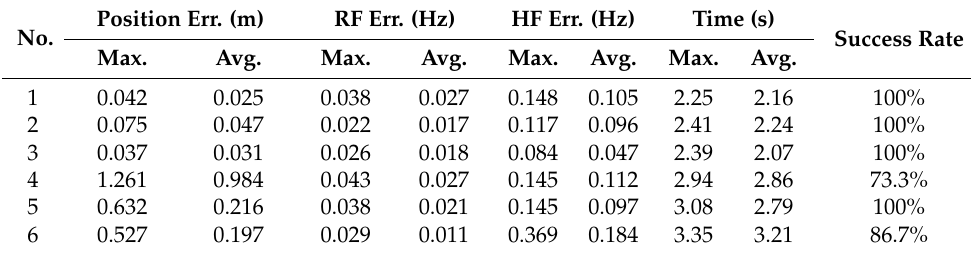
Table 8. Key indicators of verification